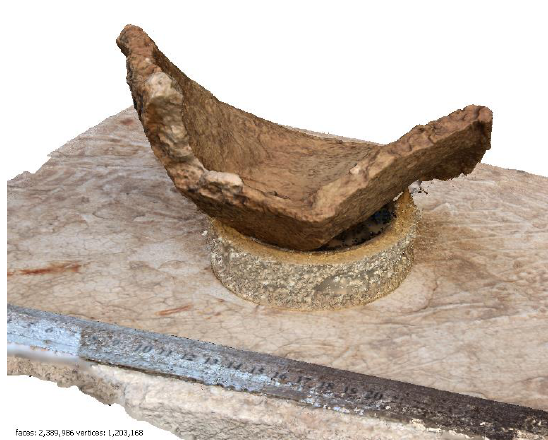
Figure 10. Detail of the point cloud after data cleaning